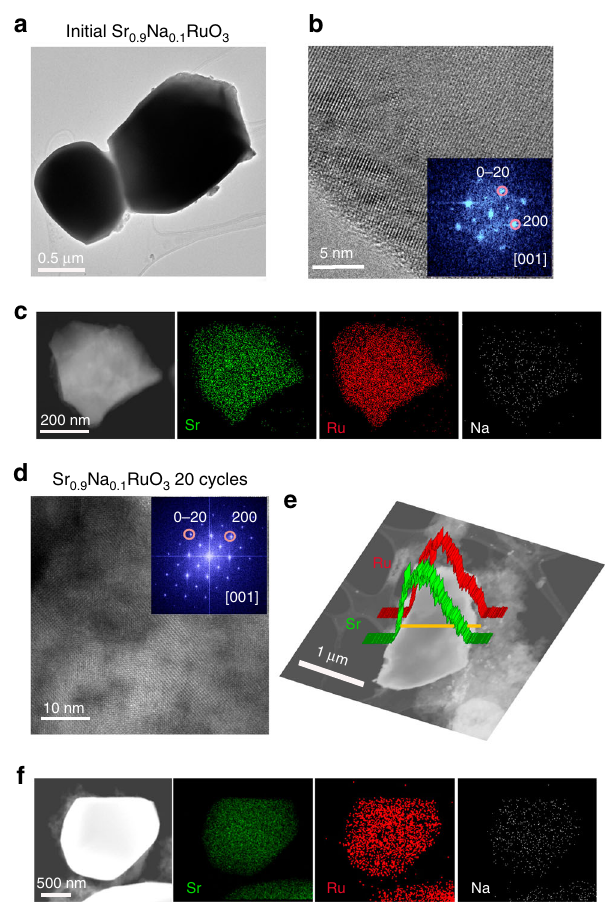
Fig. 4 Evolution of Sr 0.90 Na 0.10 RuO 3 during OER. a TEM, b HRTEM/DDP, and c STEM-EDX mapping of Sr 0.90 Na 0.10 RuO 3 before the OER reaction. d HRTEM/DDP images, e STEM-HAADF micrographs showing Ru and Sr line scan pro fi les and f STEM-EDX mapping of Sr 0.90 Na 0.10 RuO 3 after